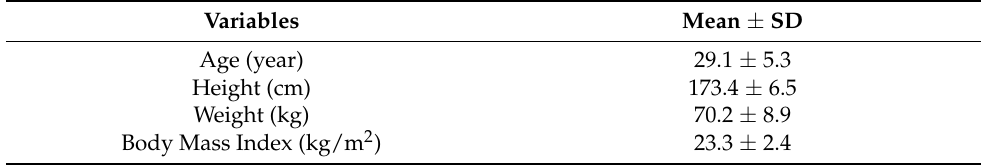
Table 1. Characteristic subjects ( n =